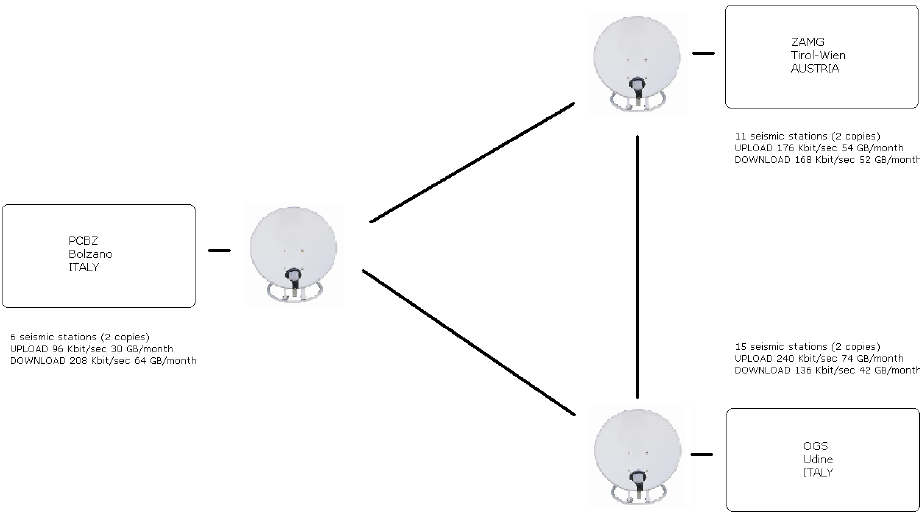
Figure 3. SeismoSAT schematic diagram with data bandwidth